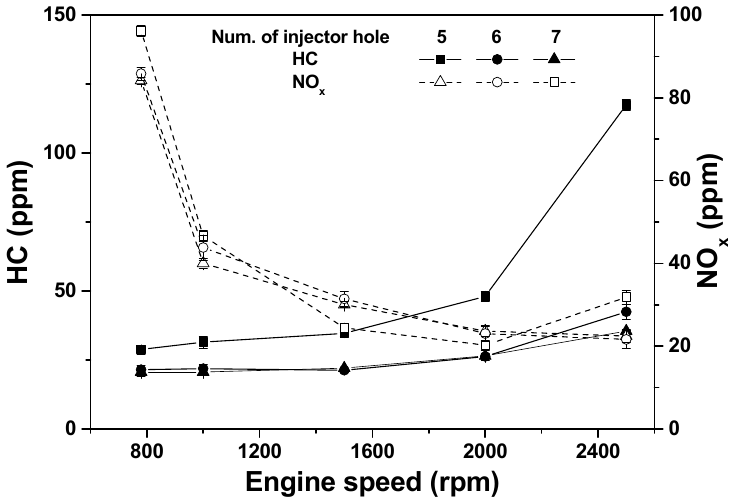
Figure 3. HC and NO x emissions with respect to number of injector holes and engine speed.